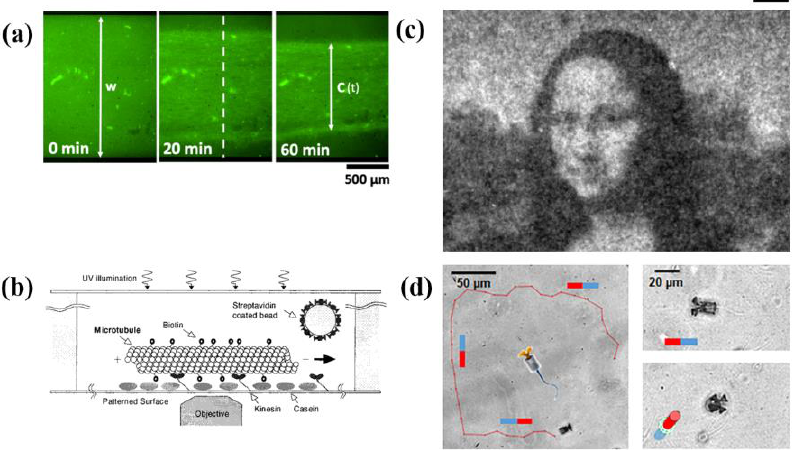
Figure 8. Using physical field to control and regulate active matter-based NMMs. ( a ) Photostimulated contraction of RCFs. Reprinted with permission from Reference [95], Copyright 2021, American Chemical Society. ( b ) The schematic of light-controlled bioshuttle. Reprinted with permission from Reference [91], Copyright 2001, American Chemical Society. ( c ) Mona Lisa pattern shown by light-controlled bacteria system. Scale bar, 100 µ m. Reprinted with permission from Reference [98] , Copyright 2018, eLife Sciences Publications. ( d ) Track of sperm cell-based NMM controlled by magnetic field. Reprinted with permission from Reference [71] , Copyright 2018, American Chemi- cal Society.